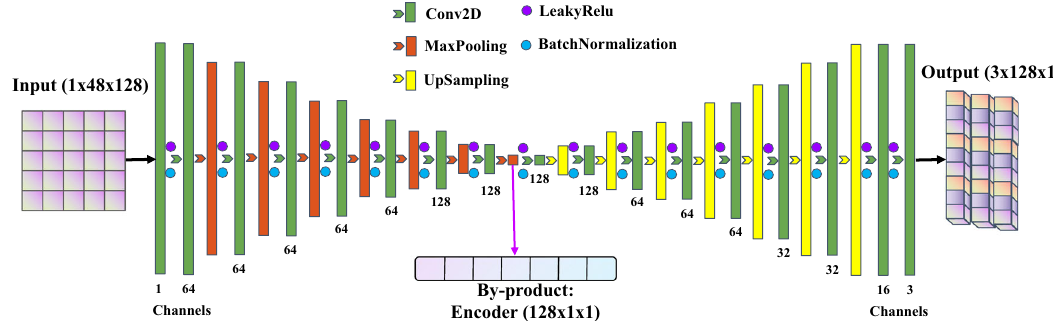
Fig. 6 The FMNet architecture. The designed FMNet contains 16 trainable layers as well as MaxPooling, UpSampling, LeakyRelu, and BatchNormalization layers. The input data have the size of 1 (channel of input) × 48 (3-C waveforms of 16 seismic stations) × 128 (trace length). The left part of the FMNet gradually compresses the input data from 1 × 48 × 128 to 128 × 1 × 1, and then the right part of the FMNet gradually expands the extracted features from 128 × 1 × 1 to 3 × 128 × 1 as the output of three Gaussian probability distribution representing the three angles of the focal mechanism. The intermediate layer of the encoder, with the size of 128 × 1 × 1, is also exported as a by-product to interpret the neural